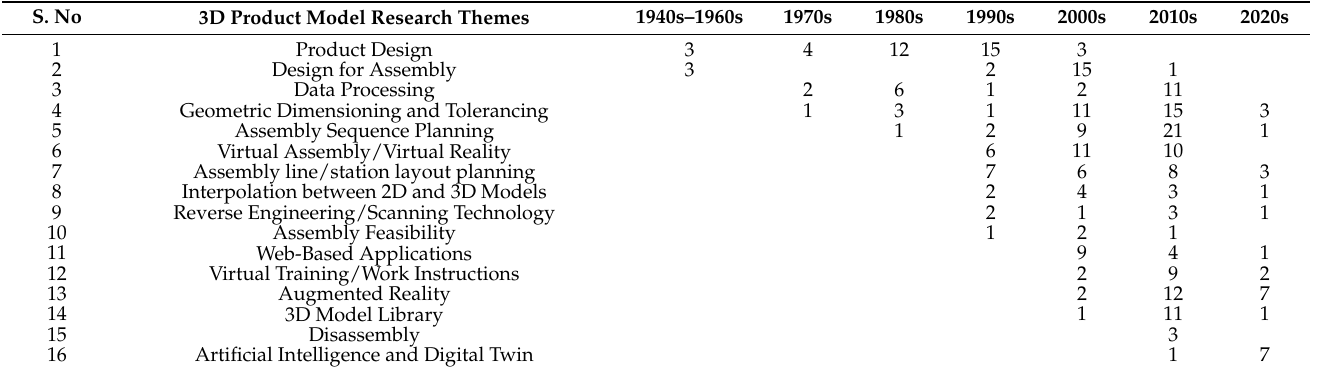
Table 4. Three-dimensional (3D) product model research themes evolution with journal article count.